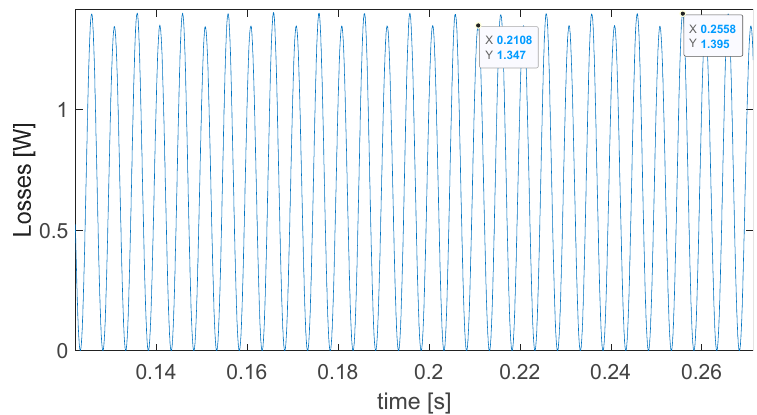
Figure 3. Parameter estimation model—iron losses over time.